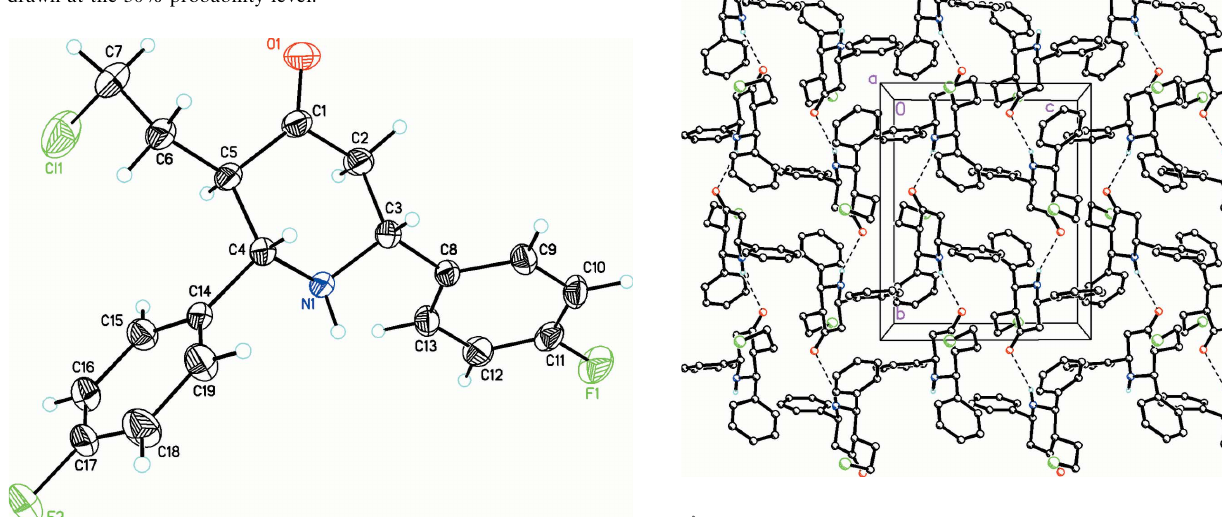
Figure 3 A partial view along the a axis of the crystal packing for (I), showing infinite chains formed along [010] by weak N1—H1 (cid:3)(cid:3)(cid:3) O1 hydrogen bonds with the molecules rotating in a 180 (cid:2) spiral motif along the axis. H atoms not involved in this interaction have been omitted for